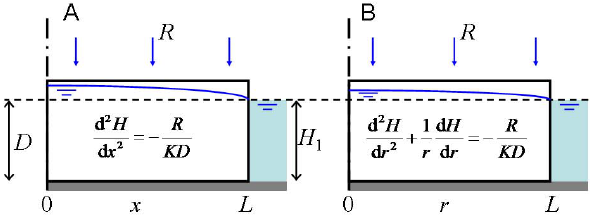
Fig. 3. Two of the three groundwater flow cases governed by linear differential equations, as given in the figure. Figure (A) reflects parallel flow in cartesian coordinates, Figure (B) depicts radial flow in cylindrical coordinates. The dashed vertical line at the left of each figure is the axis of symmetry. At L , the groundwater body is in contact with open water. The open water and the aquifers are bounded below by an impermeable base. Further details are in the